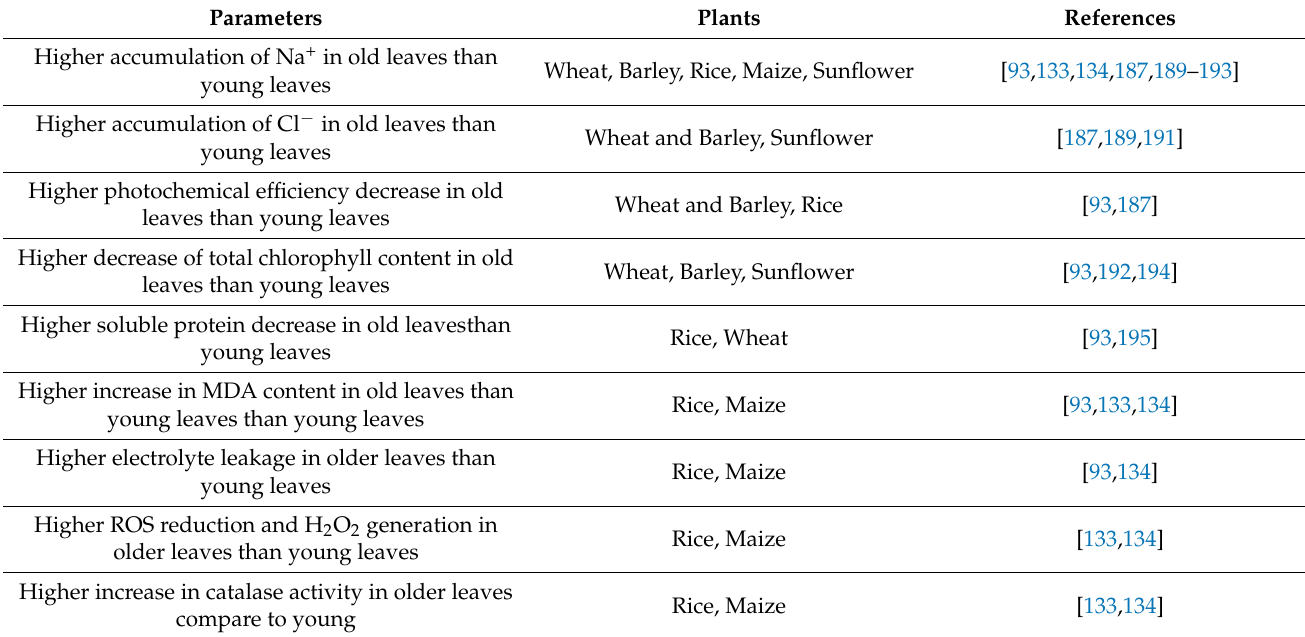
Table 3. Differences in old and young leaves of crop plants triggered by salinity stress. Parameters Plants